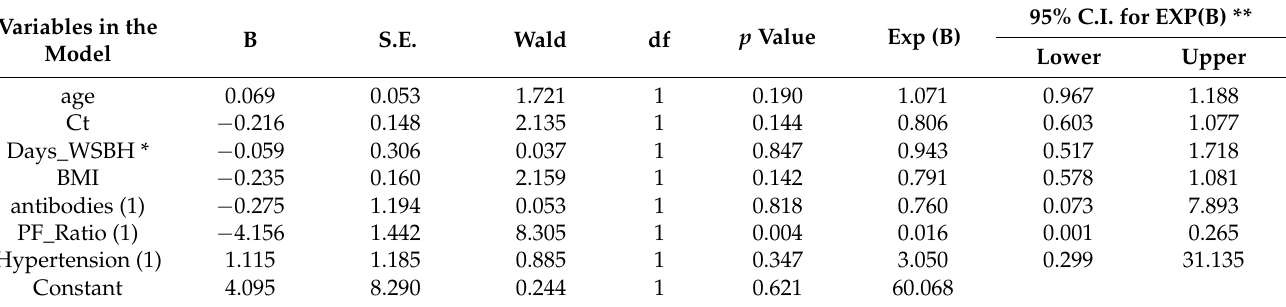
Table 4. Results of the multiple regression analysis with respect to the variables affecting the outcome of COVID-19 disease in fully vaccinated, hospitalized